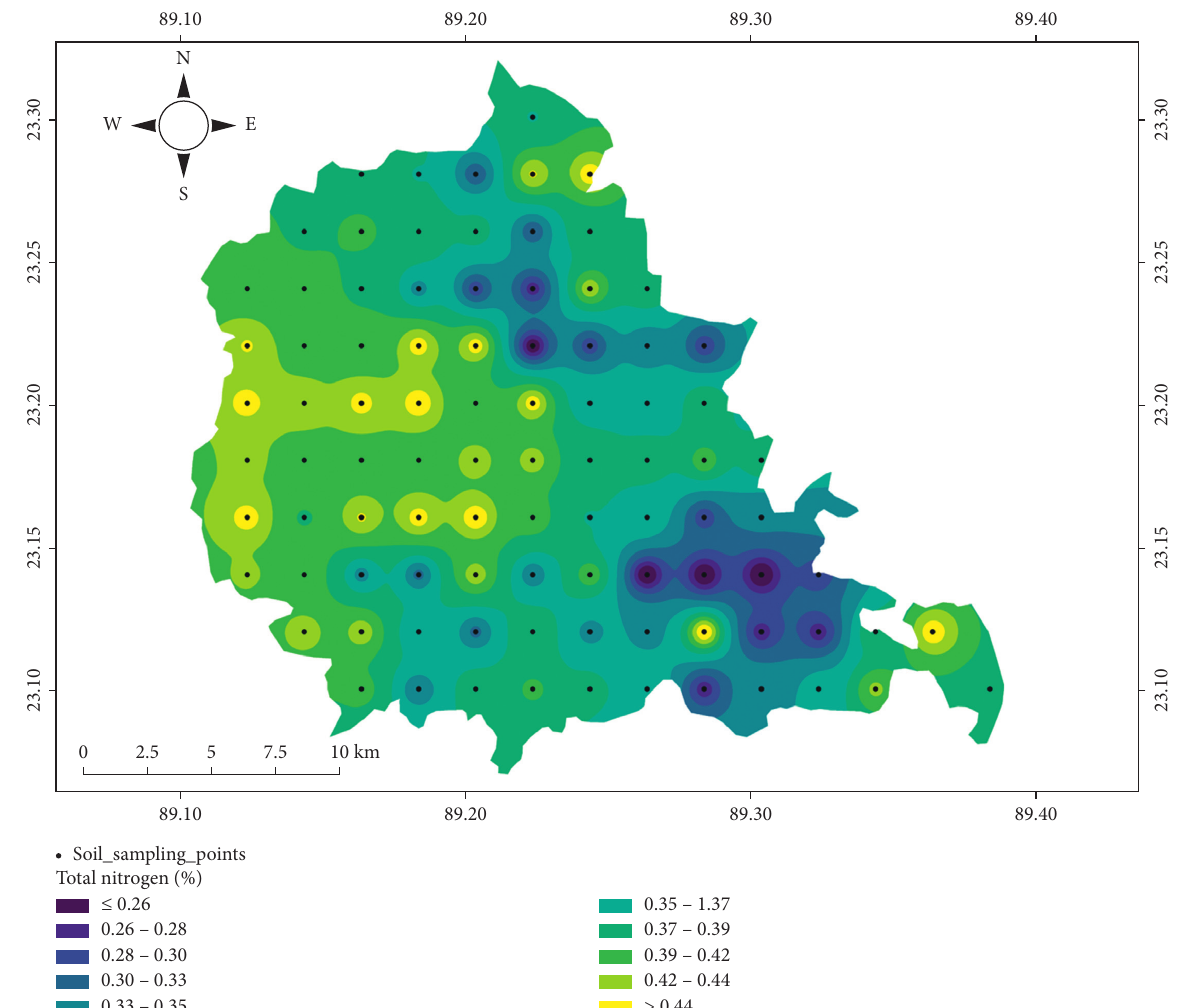
Figure 8: Spatial distribution of total soil nitrogen (total N) contents in the study